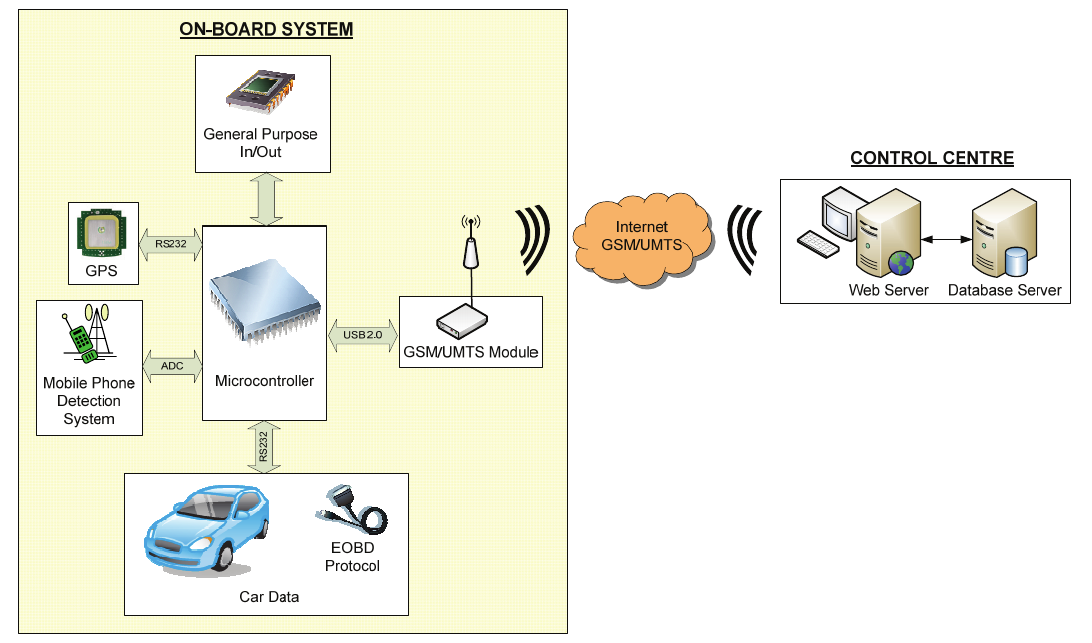
Figure 1. Block diagram of the